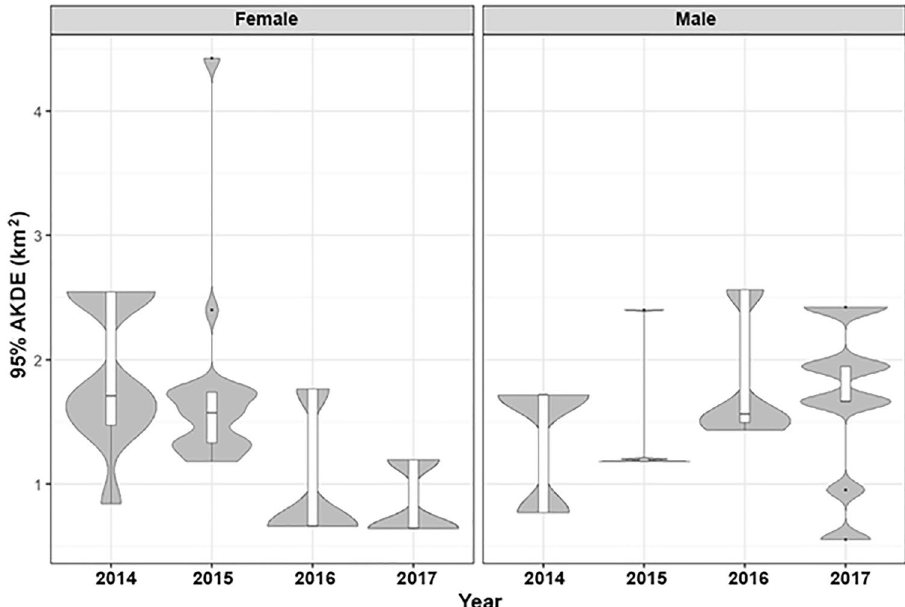
Figure 3. 95% autocorrelated kernel density estimate (95% AKDE, km 2 ) of female (left) and male (right) badgers for the different years of the study (2014–2017). The median is shown as a black horizontal line, with upper and lower quartiles (mean point between maximum/minimum data points and the median) at the top/ bottom of the bar. Whiskers (vertical black lines) denote lower and upper 25% of data values. The density distribution is shown as grey